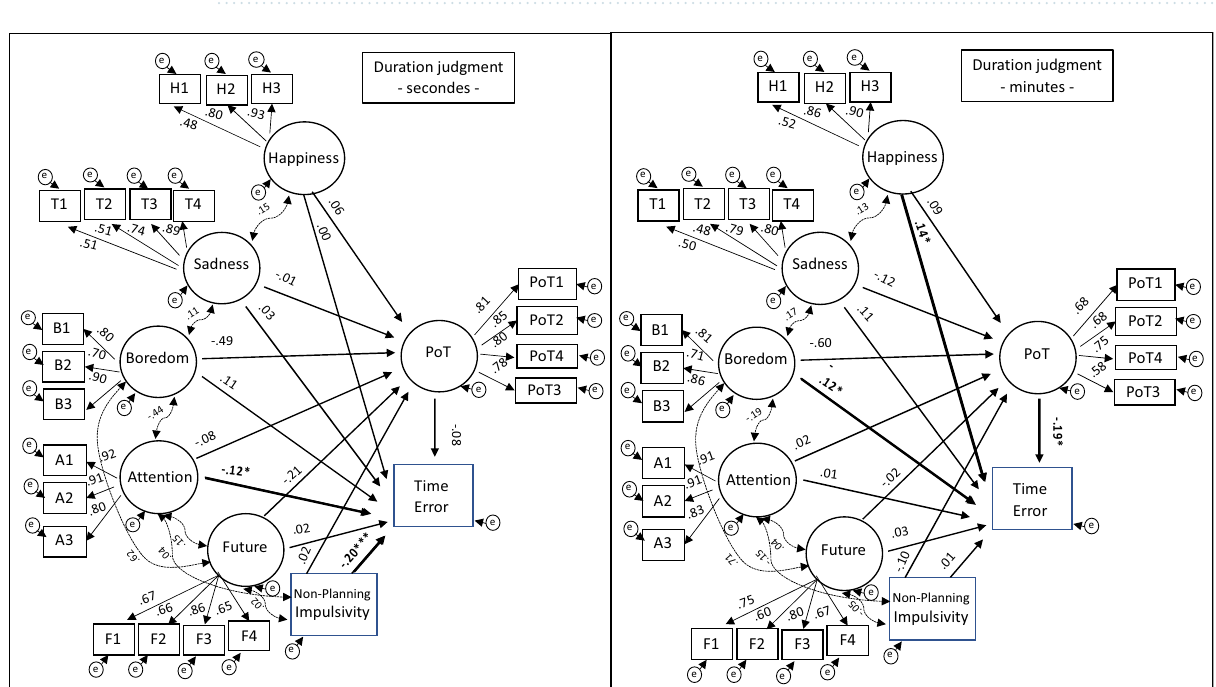
Figure 3. Structural Equation Model analyzing the relationships between variables thought to influence the Passage-of-Time judgment for the short (seconds) (left panel) and long (minutes) duration (right panel).